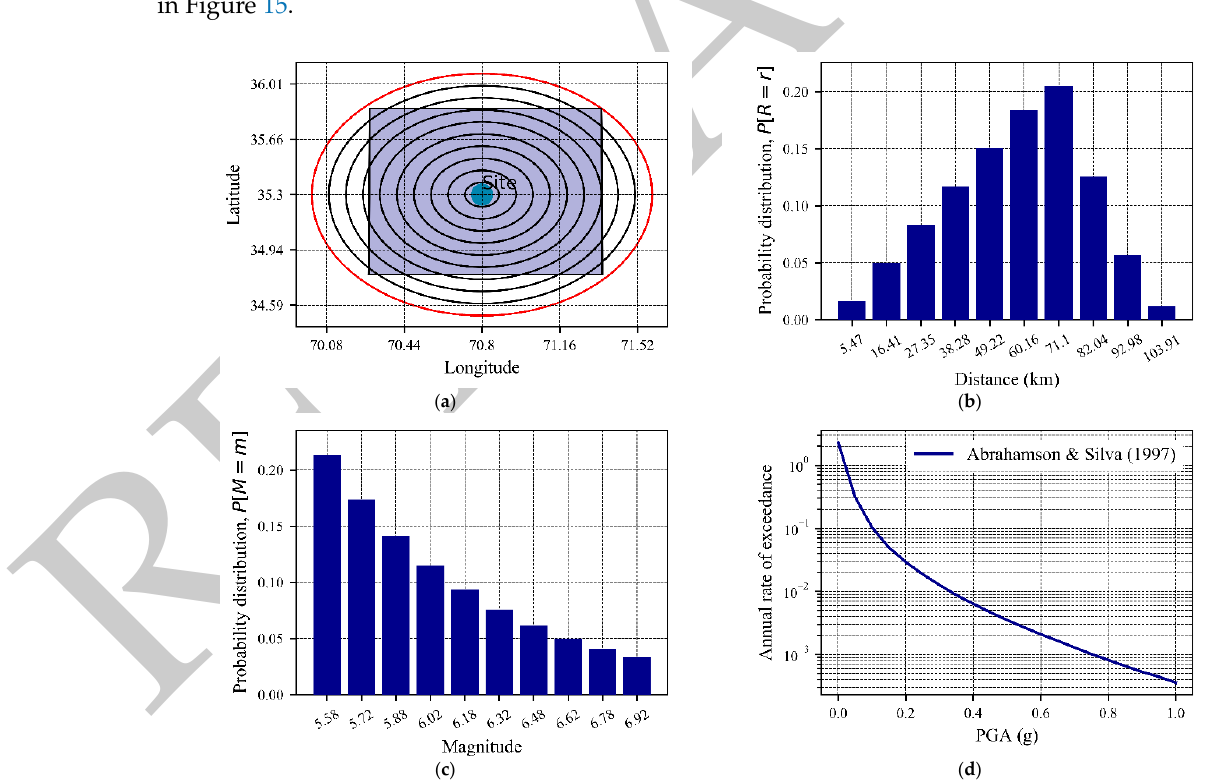
Figure 11. Area source-based test geometry and sites.